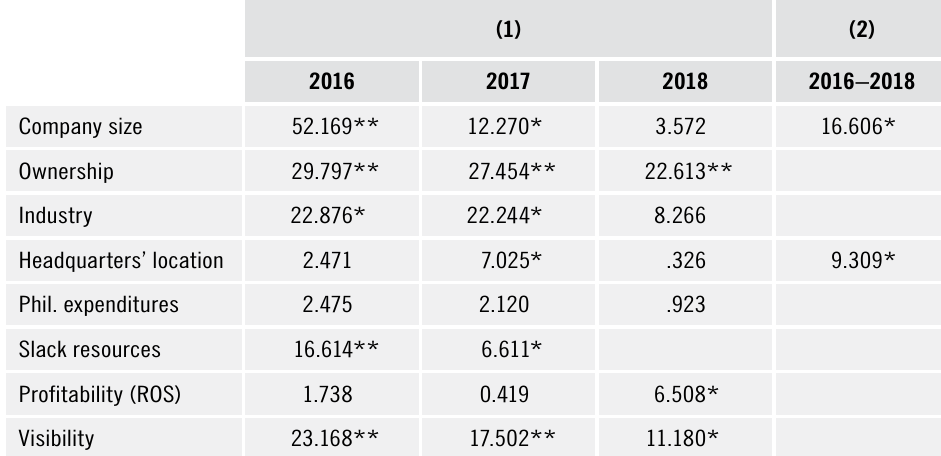
Table 6. Results of likelihood ratio tests